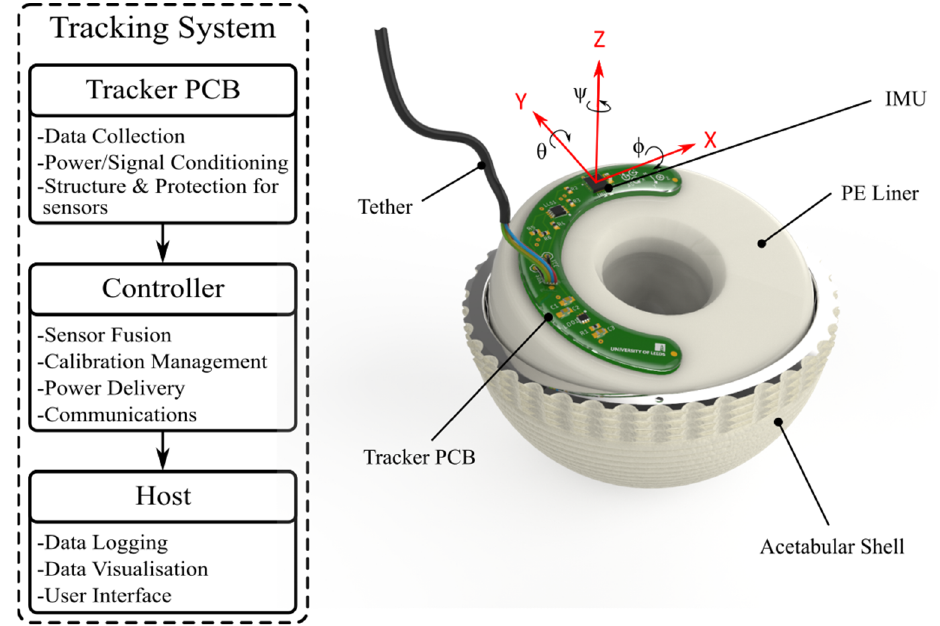
Figure 2. System level flow diagram showing the three main modules of the tracking system concept, and a PCB level render illustrating the main components of the tracker and showing how the PCB mounts to a DM liner.